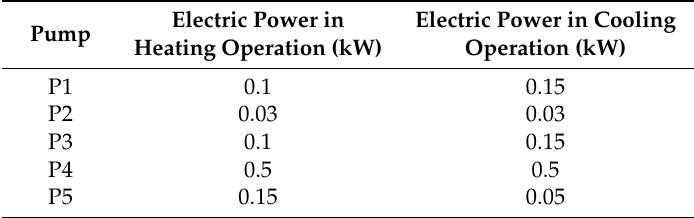
Table 4. Electrical rated power of the main circulation pumps.